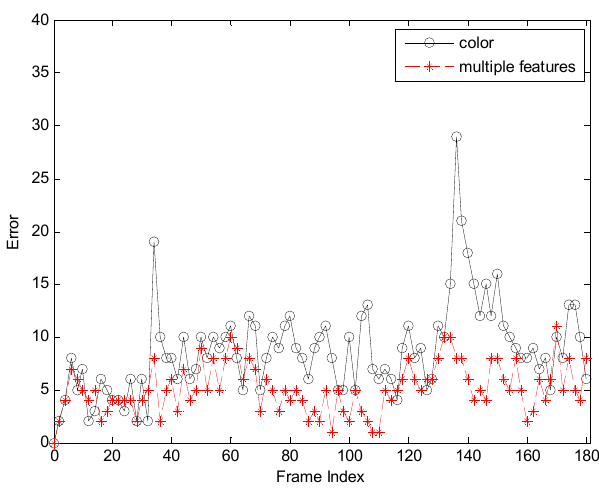
Figure 3. The RMSE comparison corresponding to illumination variation.